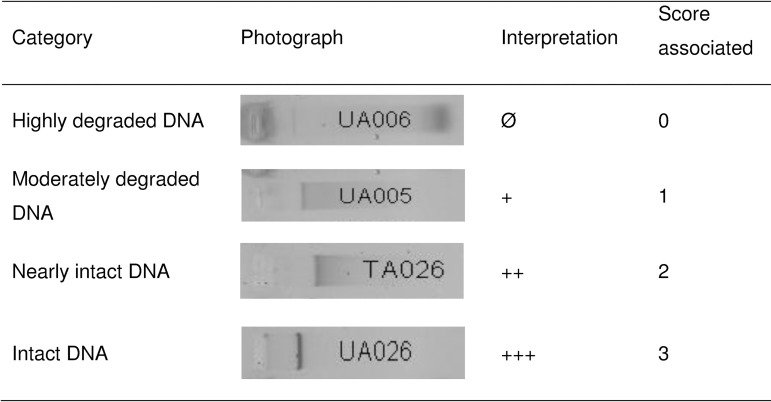
Interpretation of the genomic DNA integrity using agarose gel electrophoresis.